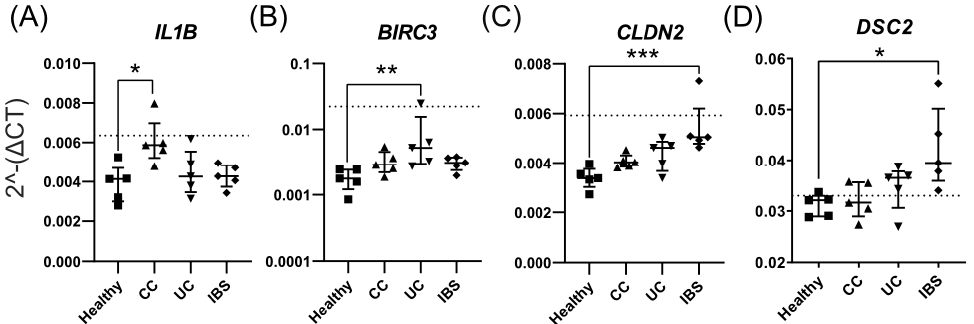
Figure 3. Comparison of gene expression of Caco-2 monolayers stimulated with fecal supernatants from healthy subjects and patients with colon cancer (CC), ulcerative colitis (UC) and irritable bowel syndrome (IBS). Caco-2 monolayers were differentiated for 20 days and stimulated apically with fecal supernatants or left untreated (medium alone) for 48 h. Gene expression of ( A ) IL1B ( B ) BIRC3 , ( C ) CLDN2 and ( D ) DSC2 was compared between healthy (square), CC (triangle), UC (inverted triangle) and IBS (rhombus). The dotted line indicates the mean gene expression of untreated Caco-2 cells (n = 3). Statistical difference between the groups was assessed by the Kruskal–Wallis test, followed by Dunn’s multiple comparisons test. * p < 0.05; ** p < 0.01; *** p < 0.001 (N = 5 for each group).